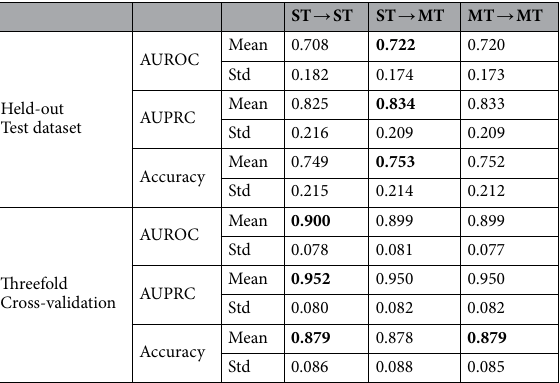
Table 3. Comparison of the various knowledge distillation model results. Knowledge distillation models are represented as teacher → student. The left side of the arrow indicates the teacher model, and the right side of the arrow indicates the student model (ST: single-task learning model, MT: model of multi-task learning with similar tasks). Significant values are in bold.